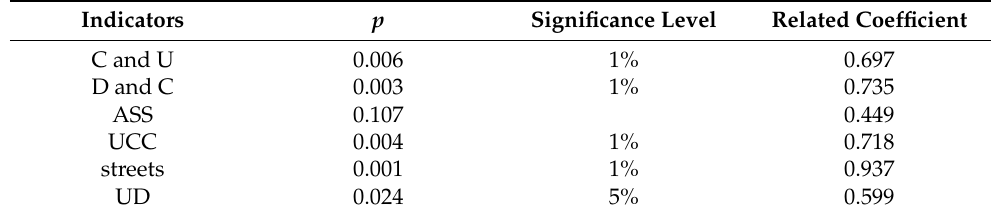
Table 7. Correlation between detailed indicators of urban functional areas and the development of warehouse